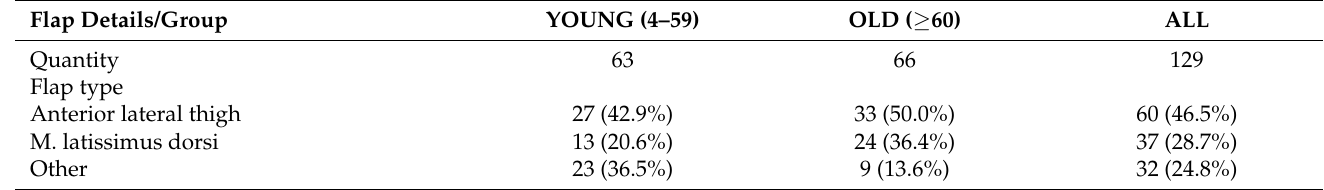
Table 3. Presentation of the characteristics of the performed free flap plastic surgeries of the studied cohort of patients and the division into the two groups (YOUNG,